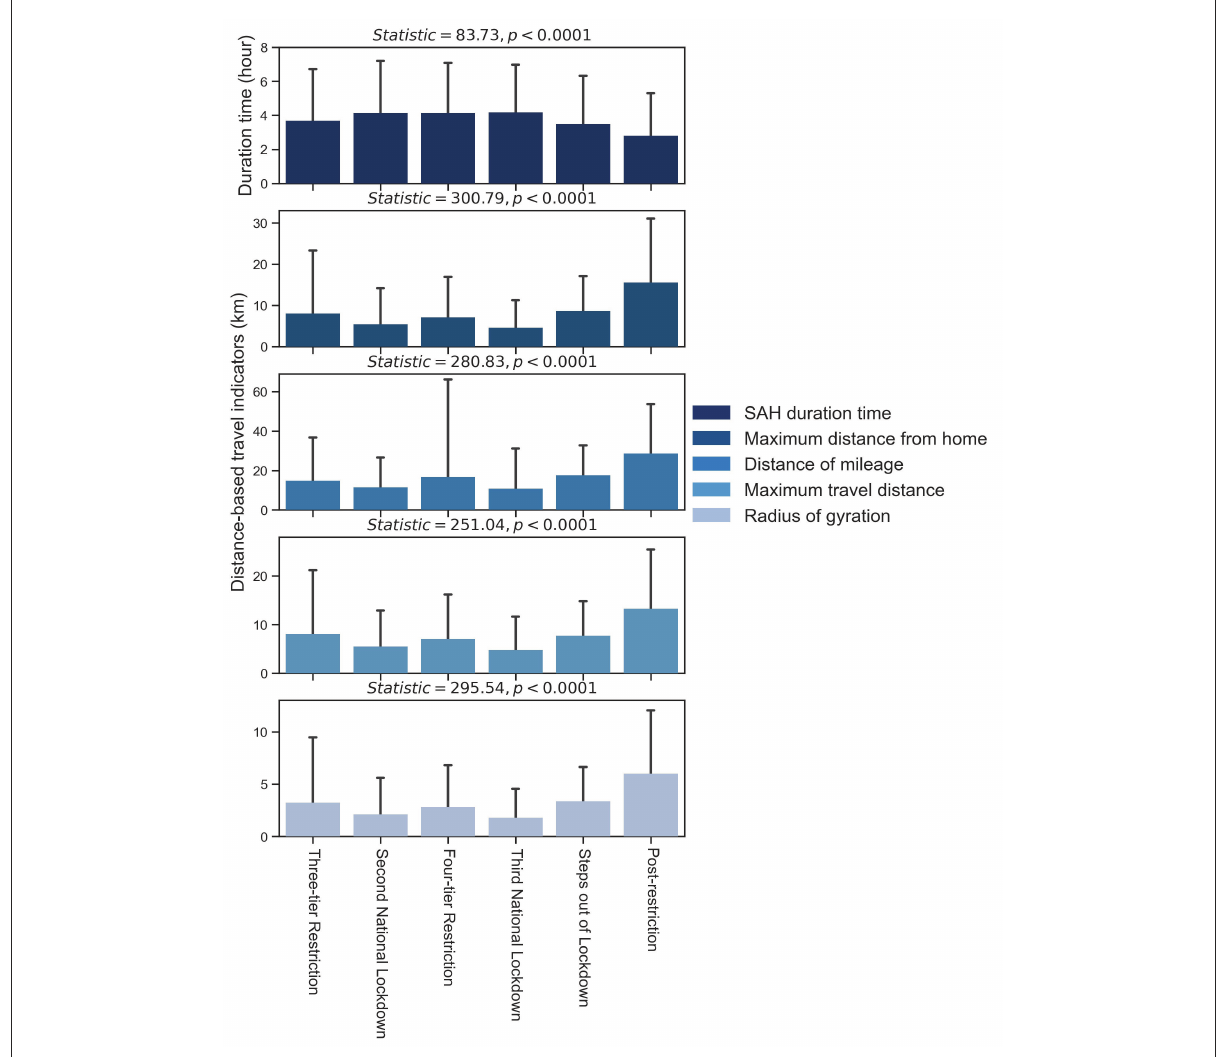
FIGURE3 Stay-at-home and travel indicators variations (mean and standard deviation) in the different policy restriction